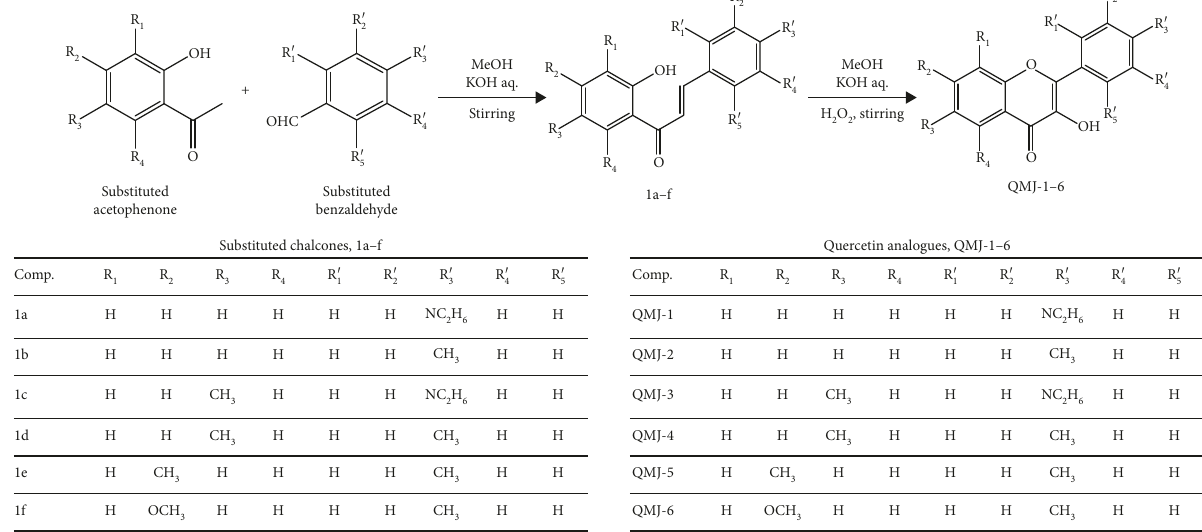
Figure 1: Synthesis of 3-hydroxyflavone analogues was carried out by the reaction of various substituted acetophenones with substituted benzaldehyde using 40% KOH and methanol to form chalcones (1a–f). The chalcones were cyclized using 10% KOH, methanol, and 15% H 2 O 2 to produce 3-hydroxyflavones